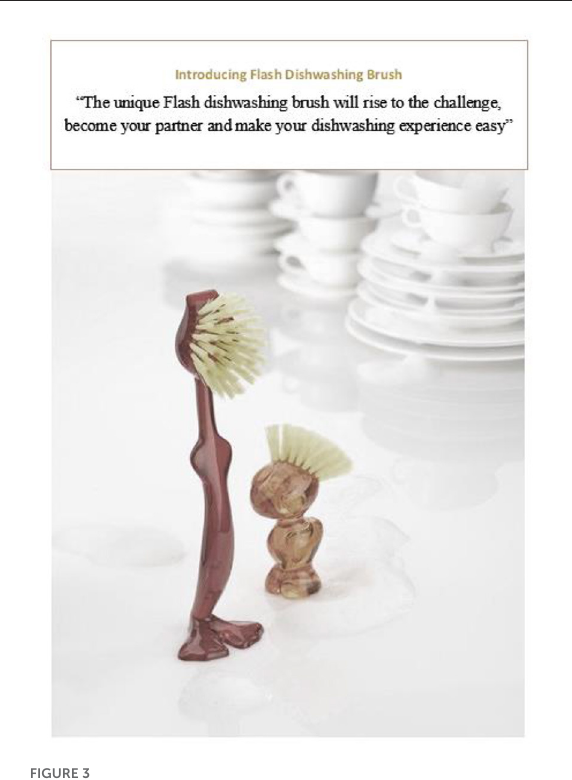
FIGURE3 Advertisement/stimulus for